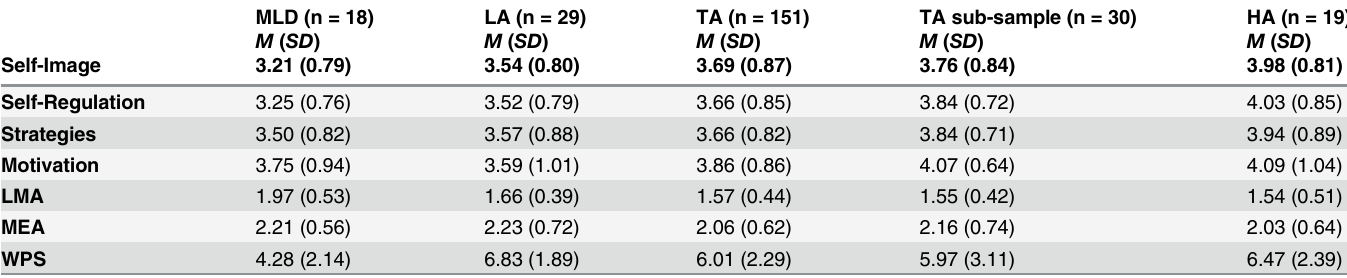
Table 3. Means and standard deviations for four mathematics achievement groups on measures of mathematical metacognition, mathematics anxiety and word problem solving.